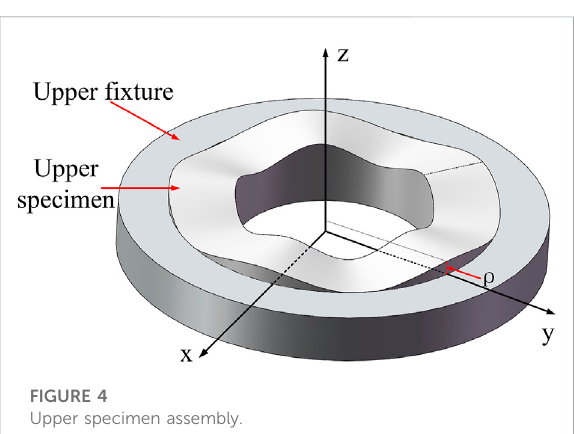
FIGURE 5 Lower specimen assembly.